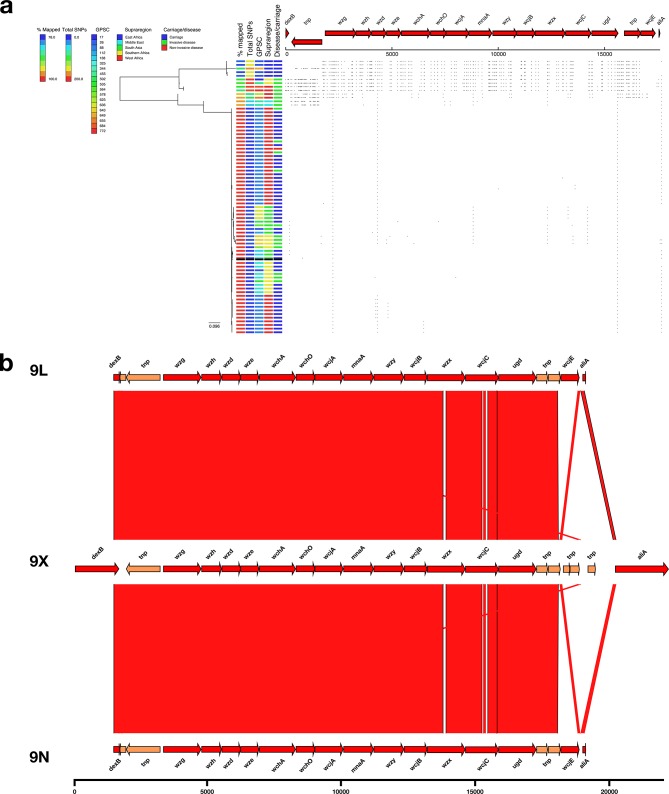
(a) Phylogeny and SNP map of serotype 9L. (b) Comparison of the putative serotype 9X sequence and the serotype 9L and 9N reference sequences.